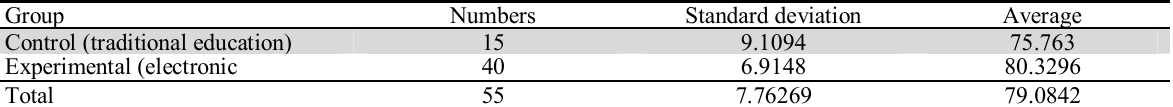
Descriptive results of posttest in cognitive growth variable in control group and experimental group Group Standard deviation Control (traditional